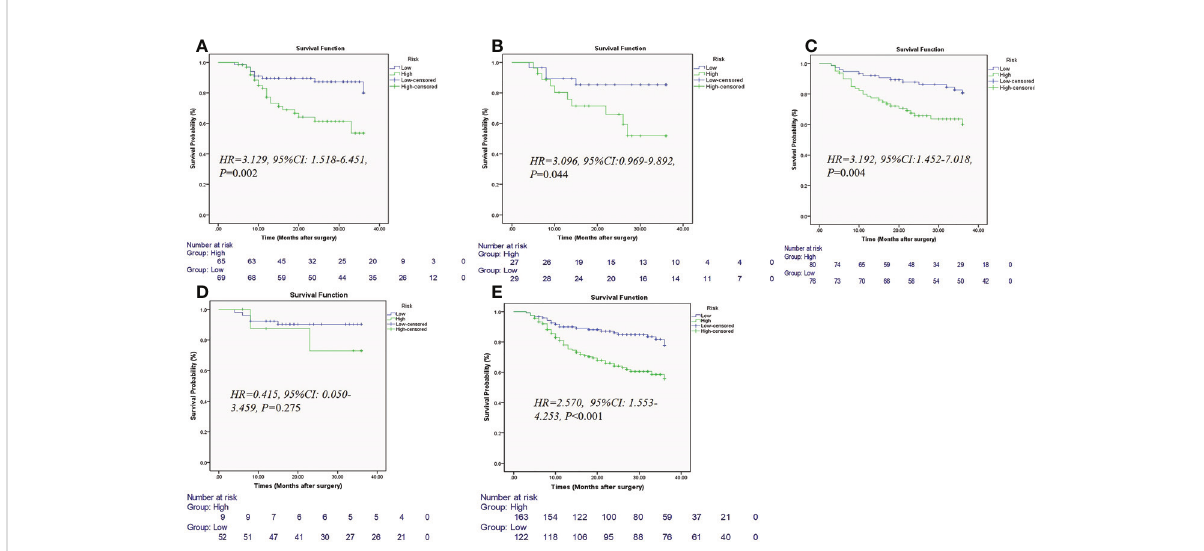
FIGURE 7 Kaplan-Meier estimates of the nomogram for predicting 3-year recurrence-free survival in patients with rectal cancer in training cohort (A) , internal validation cohort (B) , external validation cohort (C) , at T1-T2 subgroup (D) , and at T3-T4 subgroup (E)